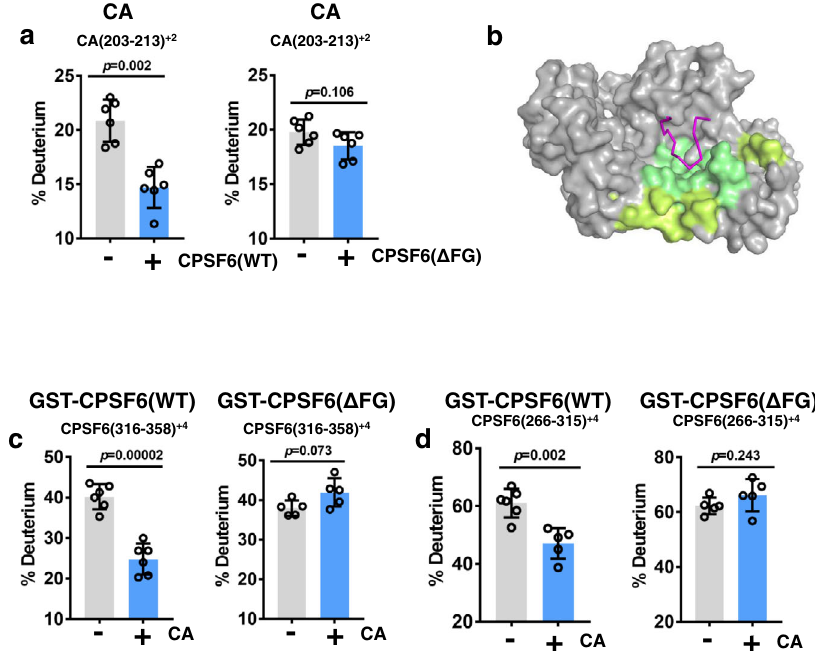
Fig. 6 | HDX-MS analysis of CPSF6(LCR-FG-LCR) binding to IP6-stabilized CA tubes. a The 10s HDX results for the CA peptide (aa 203-213) that is speci fi cally protected upon addition of WT GST-CPSF6 261-358 but not GST-CPSF6 261-358 ( Δ FG). GrayandcyanbarsshowHDXvaluesfortheindicatedCApeptideintheabsencevs presence of added GST-CPSF6. Consolidated results from differential HDX-MS for protectioninCAareshowninSupplementaryFig.14a). Theaverageddata(+/ − SD) from six independent experiments are shown. Statistical analysis of samples was carried out with Student ’ s two-sample, two-tailed t -test. Source data are provided as a Source Data fi le ( b ) Our X-ray structure of the CA hex +IP6+CPSF6 313-327 with protectedCAregionscolored according to thescale barinSupplementary Fig.14a and the regions showing no signi fi cant protection colored gray. For clarity, only one hydrophobic pocket formed by two adjoining CA monomers (colored gray) is